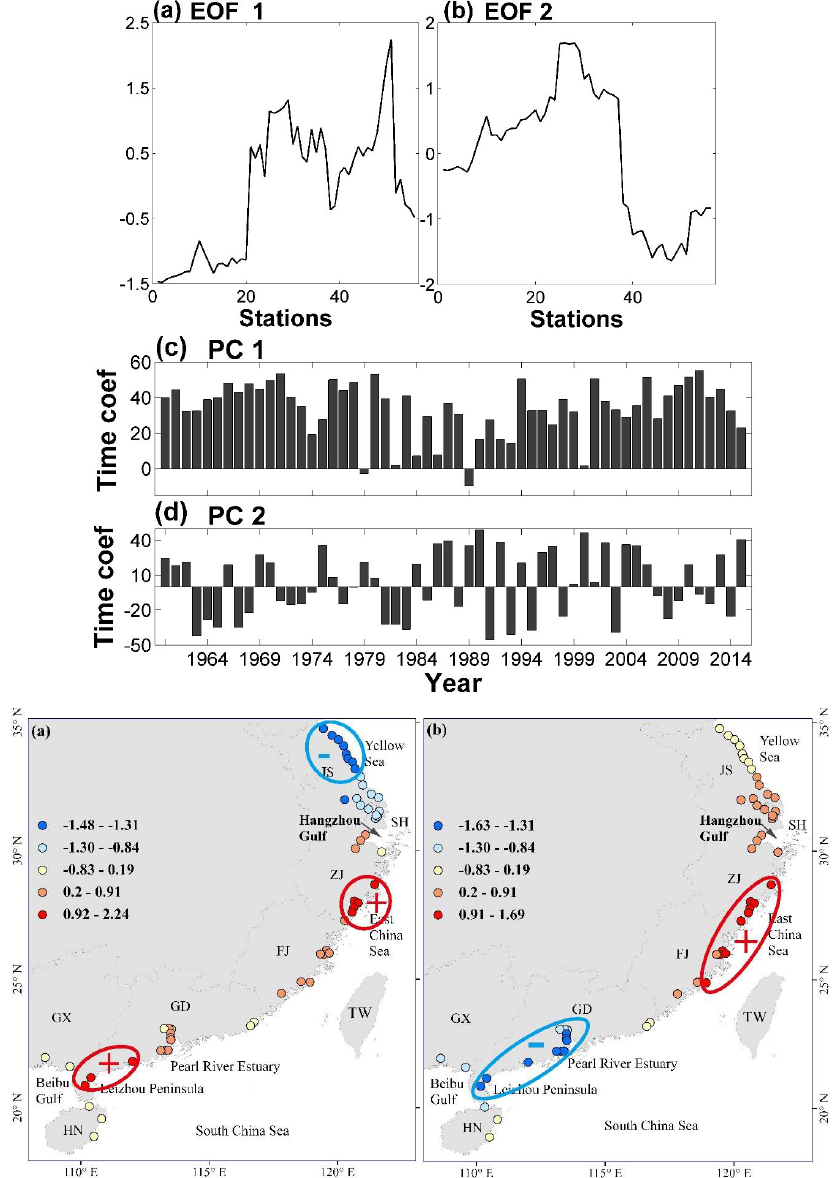
Figure 5. ( a–d ) The first two leading EOF modes of ASPI and corresponding principal components (PCs) from 1960 to 2015. According to the above temporal pattern, we divided the entire time series into three periods. The first period is from 1960 to 1979. In this period, the time coefficient of the first leading mode was